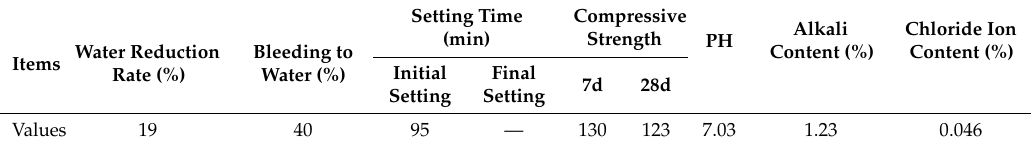
Table 2. Properties of the superplasticizer used in this